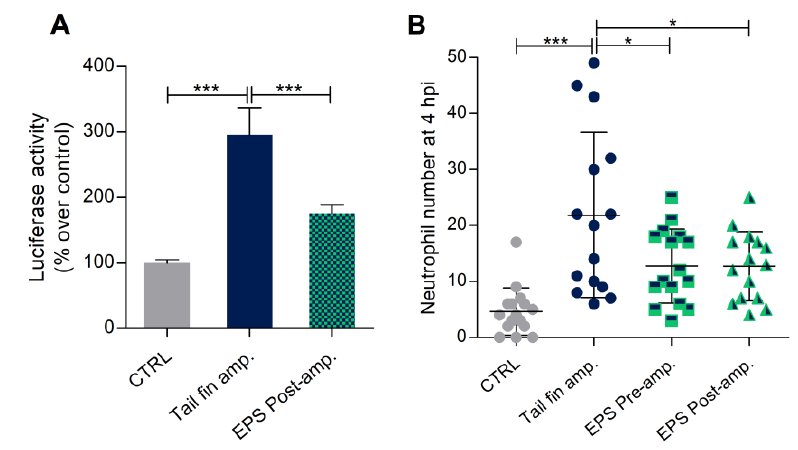
Figure 7. Anti-inflammatory effects of Phormidium EPS after caudal fin amputation induced inflammation in zebrafish larvae. ( A ) Recovery from inflammation was analyzed with the zebrafish transgenic line NF κ B:GFP,Luc. EPS treatment determined a significant reduction of Luciferase activity recorded 48 h after fin amputation. ( B ) EPS treatment significantly decreased the number of neutrophils in the damaged area of 3 dpf tail fin amputated larvae in LysC:DsRed background. The data represent the mean ± SEM ( A ) and the mean ± SD ( B ) of three independent experiments conducted with 12–15 larvae. amp. = amputation. Statistical analysis was performed using GraphPad Prism 7 (one-way ANOVA followed by Tukey’s multiple comparison test). Statistical significance: *** p ≤ 0.001, * p ≤